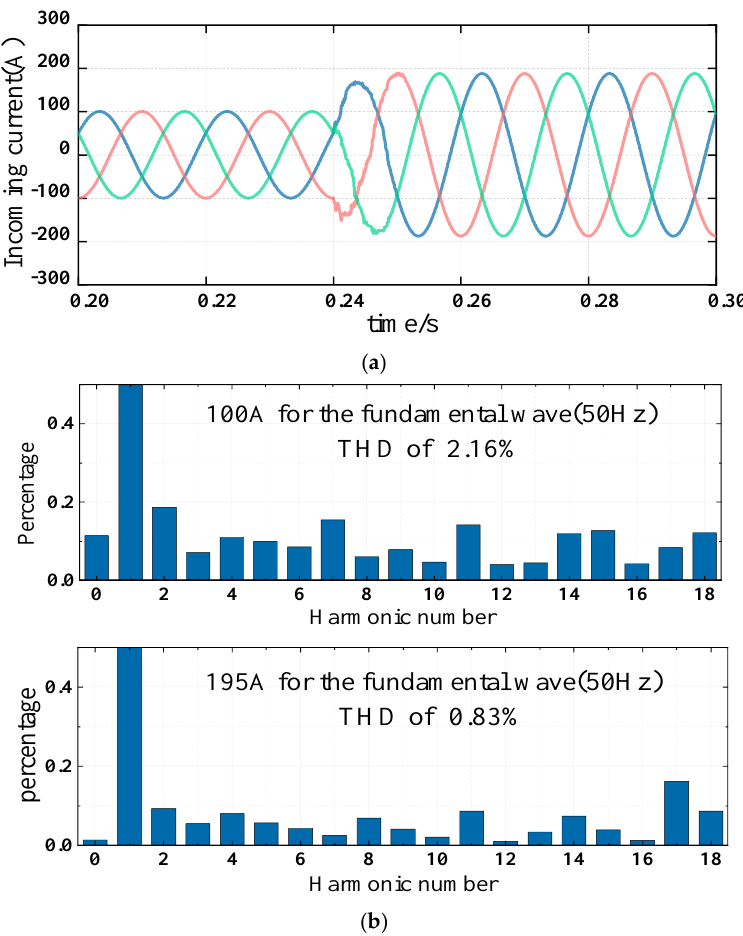
Figure 11. Analysis of i M waveform and FFT of grid current before and after power mutation. ( a ) Sudden power change before and after the incoming current i M ; ( b ) FFT analysis of grid-connected currents before and after sudden power